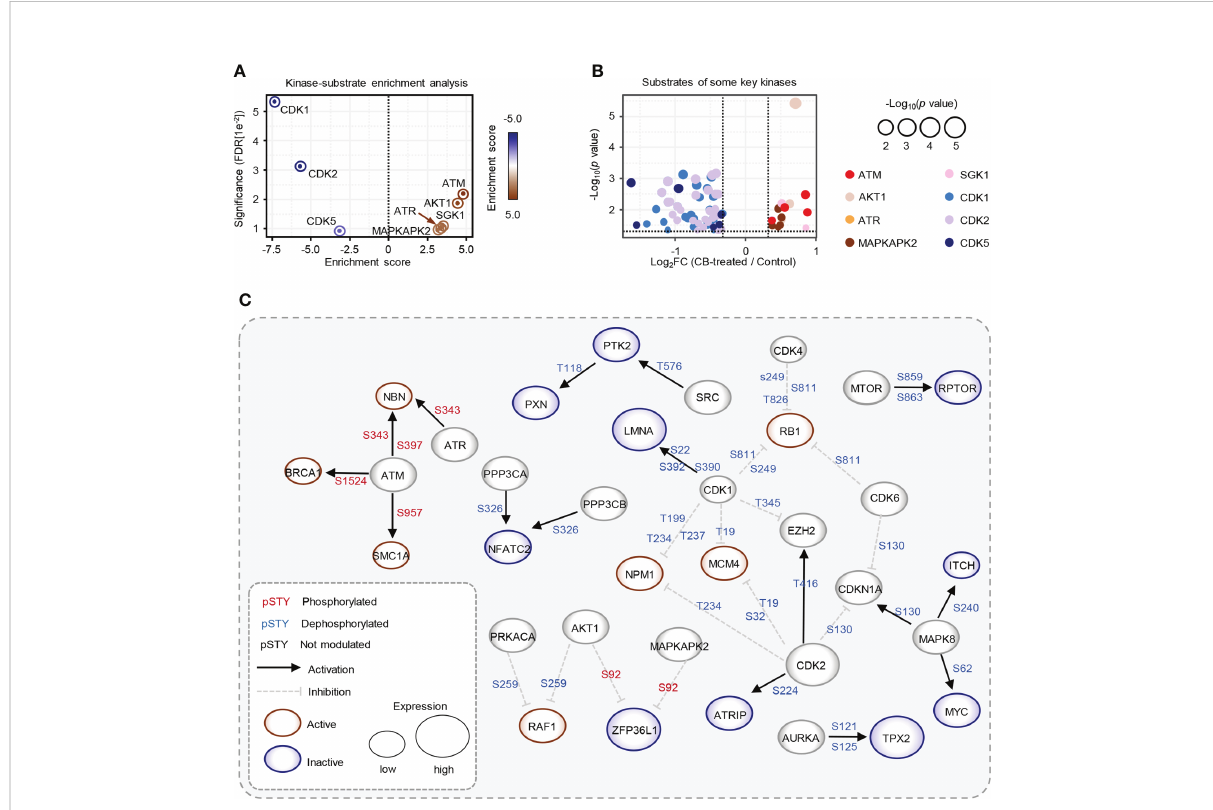
FIGURE 4 Key kinases involved in CB treatment of RBE cells. (A) Evaluation of kinase activities by KSEA in CB-treated RBE cells. (B) Scatter plot of the signi fi cantly changed substrates of key kinases. The color represents different substrates of kinases that showed in Figure 4A. (C) The phosphoproteome alterations in response to CB treatment were mapped to a literature derived signal network using the SIGNOR 2.0 database. The node size is proportional to the level of protein expression. Blue and red nodes mean inactivated and activated, respectively. Phosphorylation and dephosphorylation reactions on speci fi c residues are represented by edges between